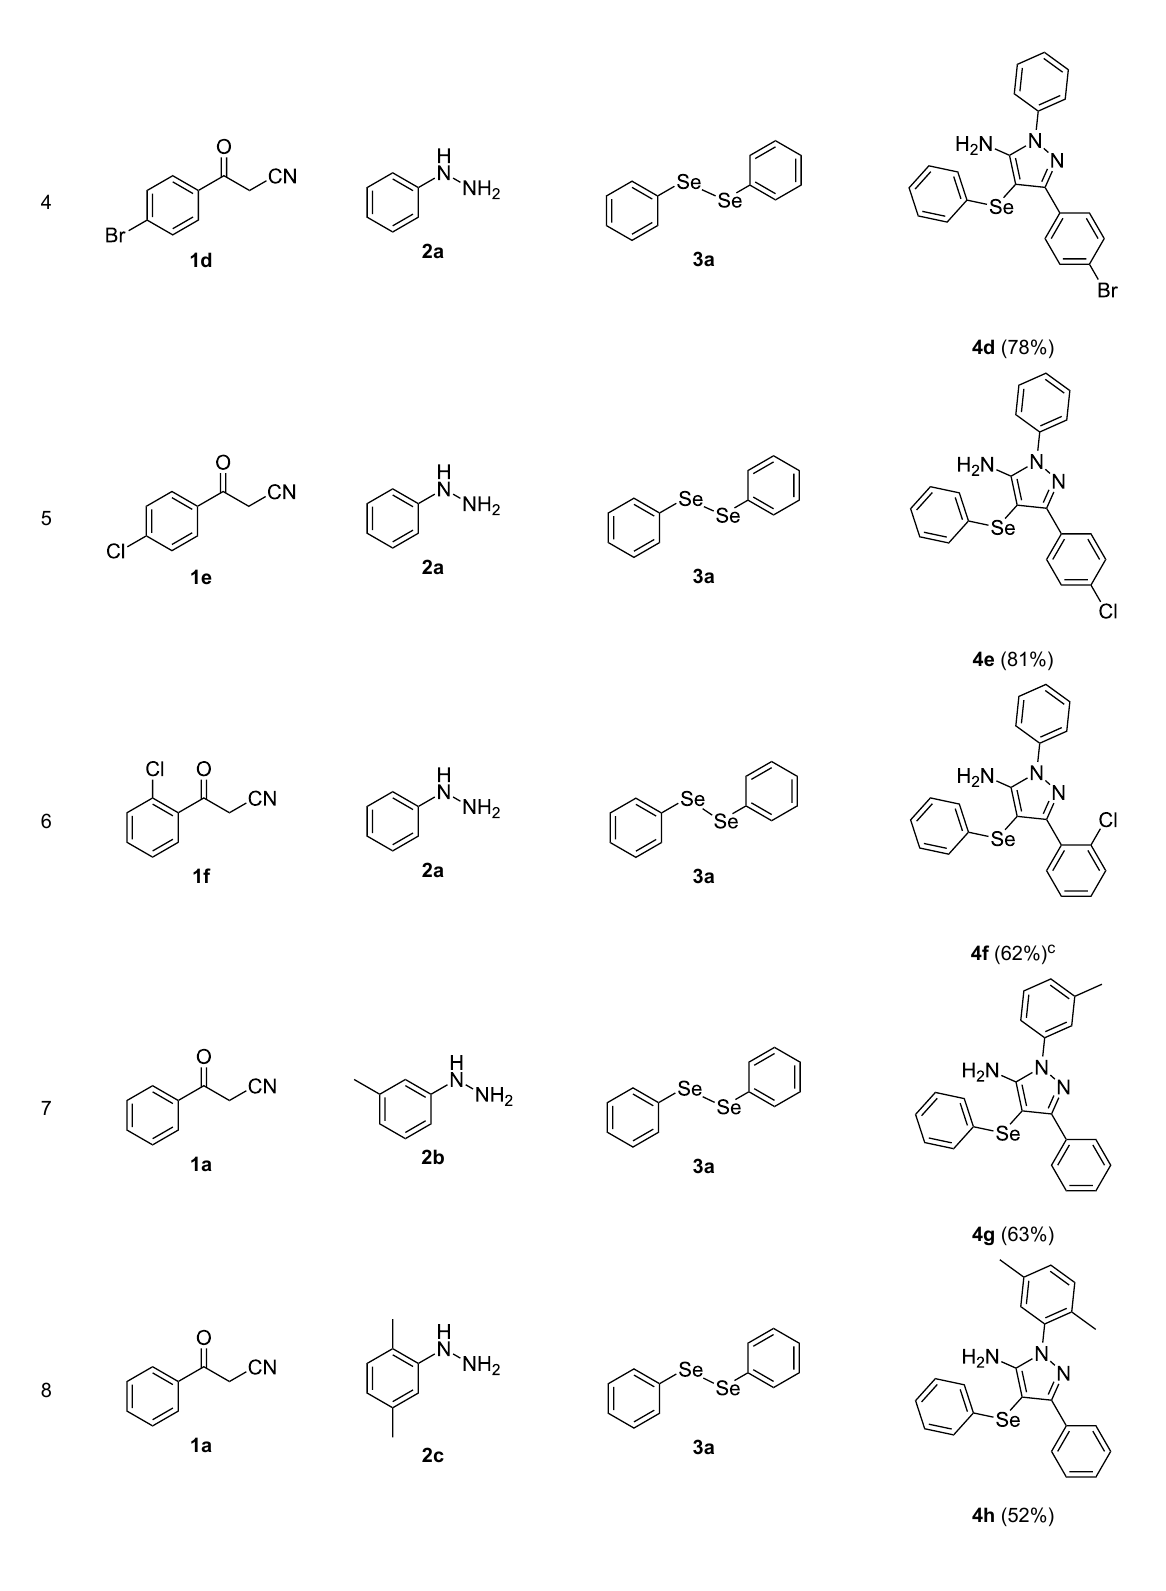
Table 2: Substrate scope for the synthesis of 5-amino-4-(arylselanyl)-1 H -pyrazoles 4 . a